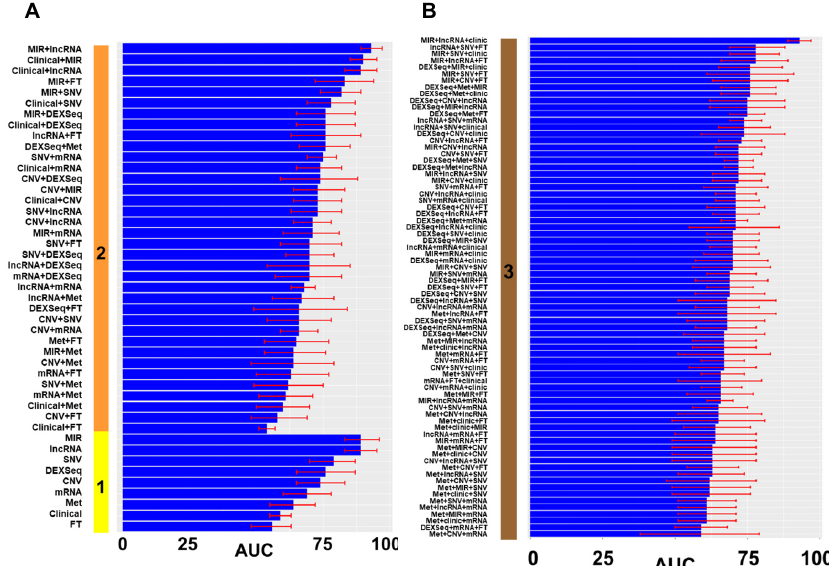
Figure 3. Performance of prediction models of optimal cytoreduction. ( A ). The solid vertical bar represents the number of types of data: 1 (yellow): only one variable was included in the model; 2 (orange): a combination of 2 types of variables. ( B ). Panel with combination of 3 types of variables: solid vertical line with 3 tags (maroon). Different performances on both panels are displayed in ascending order. The x axis is the AUC as a percentage (0–100%). The red error mark displays the 95% confidence interval (CI). Overall, 120 models with different combinations of data were tested. FT: fusion transcripts; Met: DNA methylation; SNV: single nucleotide variation; CNV: gene copy number; DEXSeq: exon expression; lncRNA: long non ‐ coding RNA; MIR: micro RNA, mRNA: gene expression. Graphics were generated with R package ggplot .